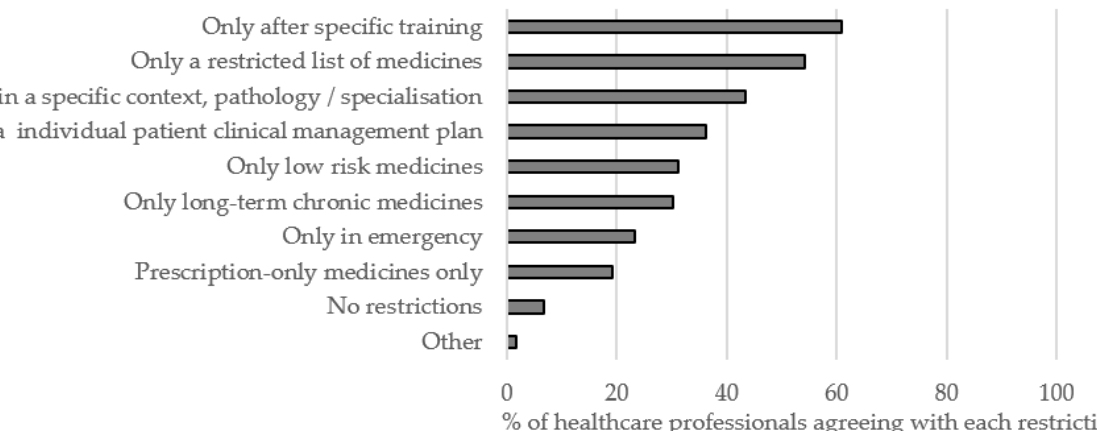
Figure 4 . Restrictions to optimize nurse prescribing in an ideal interprofessional healthcare situation ( n = 537).